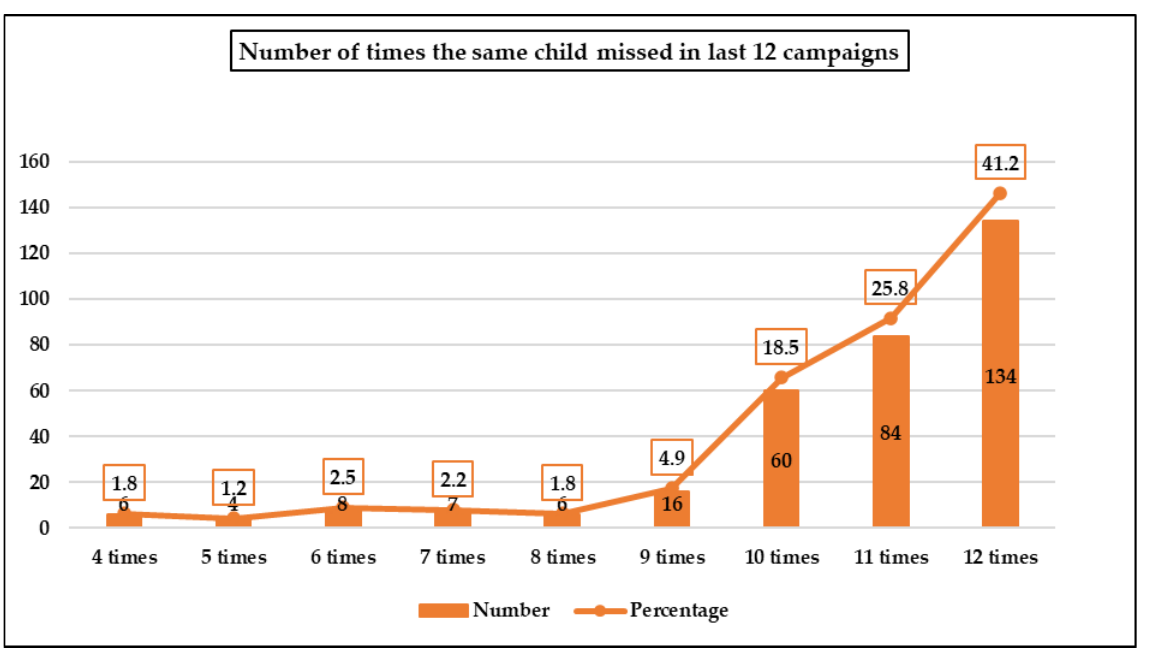
Figure 1. The number of times the same child was recorded as missing polio vaccination during the last 12 campaigns from Jan 2018 to March 2019 SIAs in 34 high-risk union councils of Karachi division, Sindh, Pakistan.